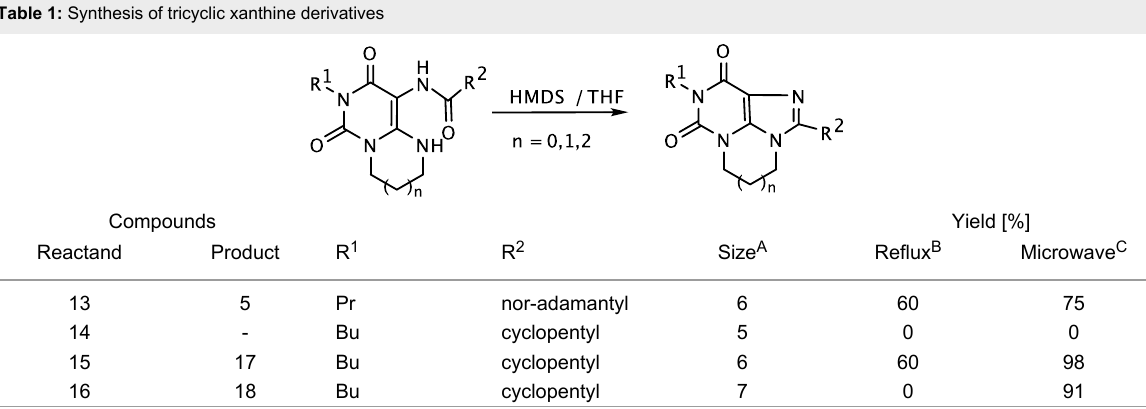
Table 1: Synthesis of tricyclic xanthine derivatives